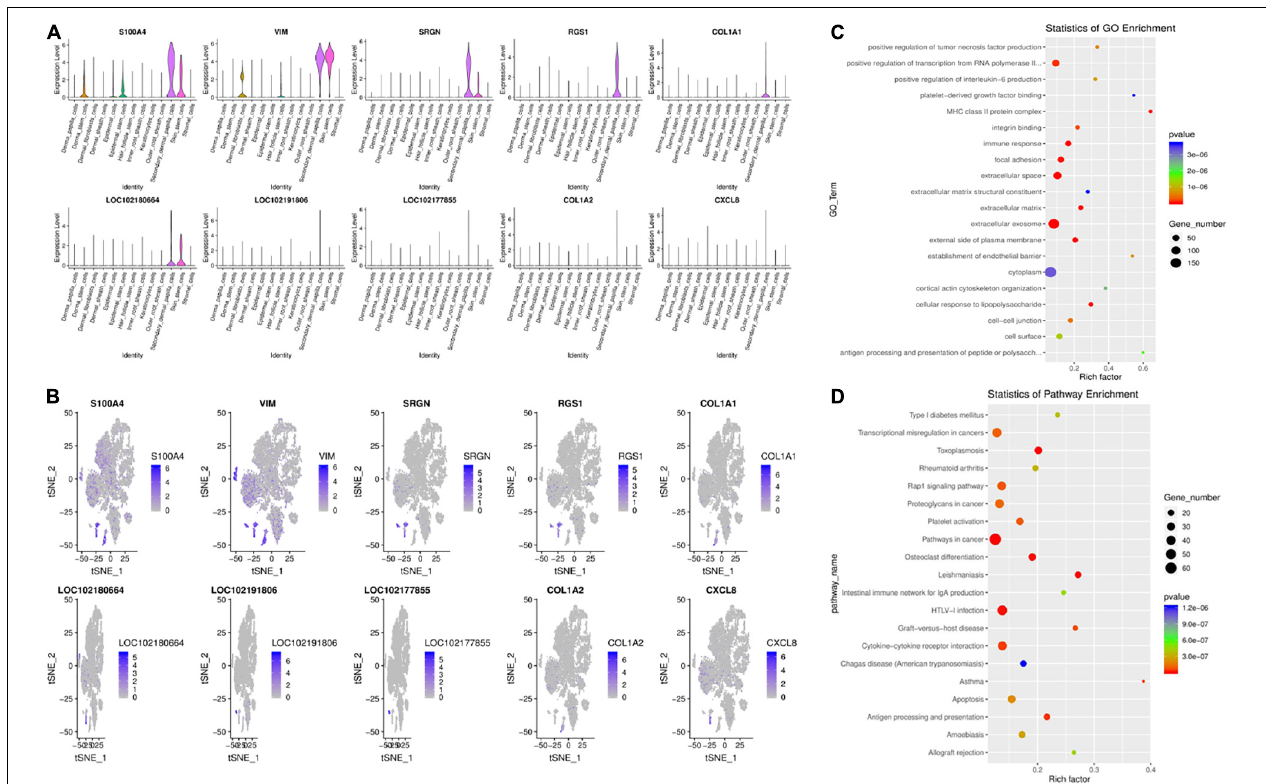
FIGURE 6 | Gene expression profiling of SDPCs. (A) Violin plots for expression of top 10 genes. (B) Relative expression levels of top 10 genes on the t-SNE plots. (C) Top 20 significantly enriched GO terms. (D) Top 20 KEGG